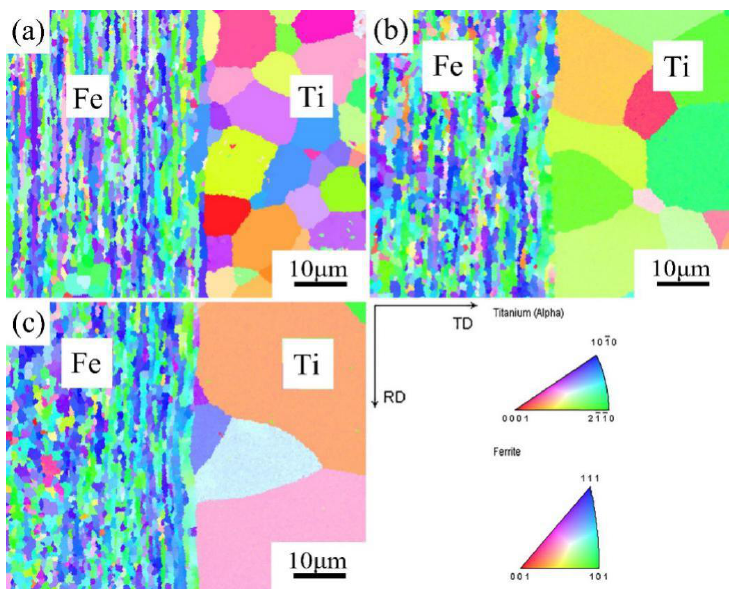
Figure 10. EBSD Inverse pole figure (IPF) mapping of TA1/Q235B sheets hot rolled at the temperature of ( a ) 1003 K ( b ) 1053 K ( c ) 1103 K.